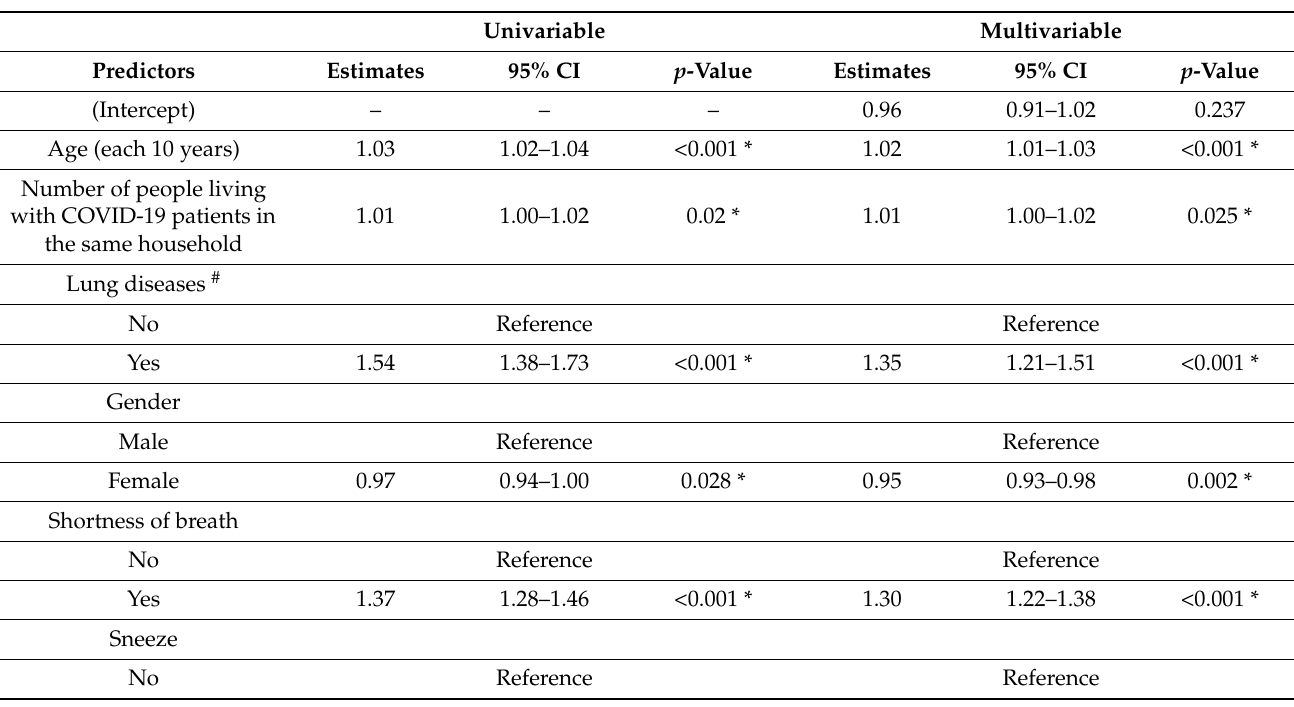
Figure 1. The relationship between the duration of COVID-19, the number of clinical symptoms, and vaccination type. Three colors have been used to represent the characteristics of COVID-19 patients, as follows: red represents patients with “first dose < 21 days”, green for “holding the second doses”, and blue for “fully vaccinated”. ( A , C ) use density histograms to show the distribution of the study subjects from the time of illness to the time of the survey, and the number of symptoms of COVID-19 patients. ( B ) uses a scatterplot to show the relationship between the duration of illness and the number of symptoms, and the size of the circle corresponds to the time between the last vaccination and the survey. Loess regression was used to draw smoothing lines according to the vaccination status of COVID-19 patients. Time of vaccination refers to the time from the last dose of the vaccine to the time of study participation. Table 3. Univariable and multivariable logistic regression model to predict low SPO 2